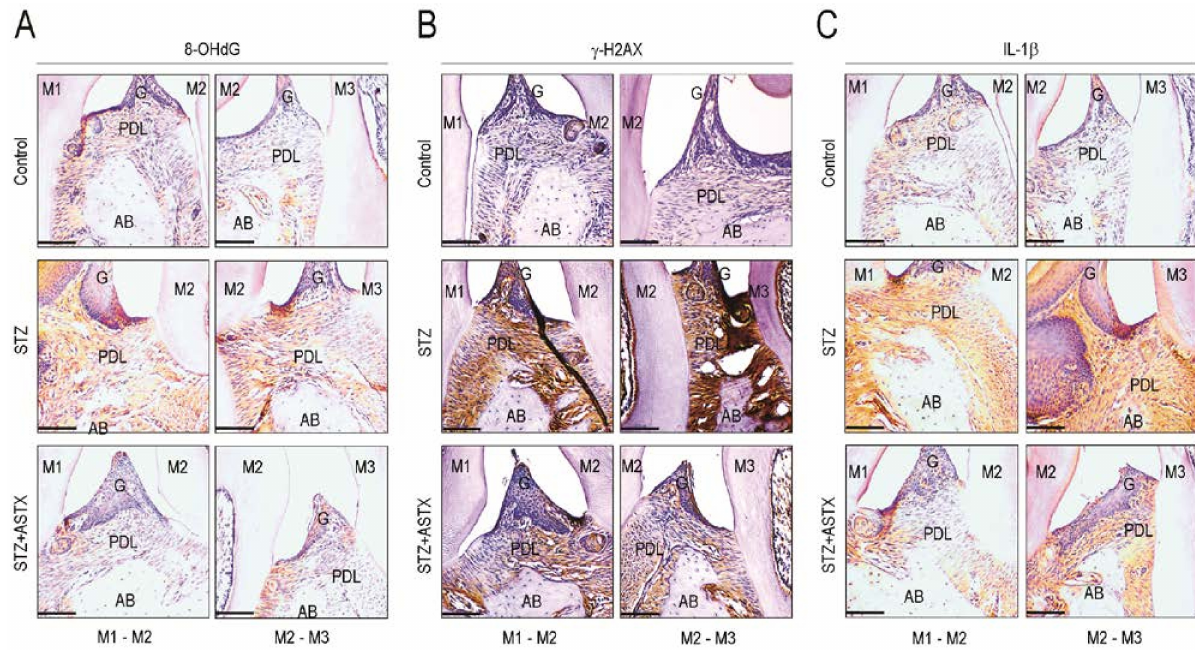
Figure 5. Supplemental ASTX inhibits oxidative stress, DNA damage, and expression of inflammatory cytokines in the periodontium of STZ-induced diabetic mice. Expression levels of ( A ) 8-OHdG, ( B ) γ -H2AX, and ( C ) IL-1 β in periodontal tissue sections including the region of maxillary molars (M1 to M3) were evaluated by IHC assay using their specific antibodies 60 days after hyperglycemia induction (200 × magnification). Bar = 100 µ m. A representative result from five different samples per each experiment is